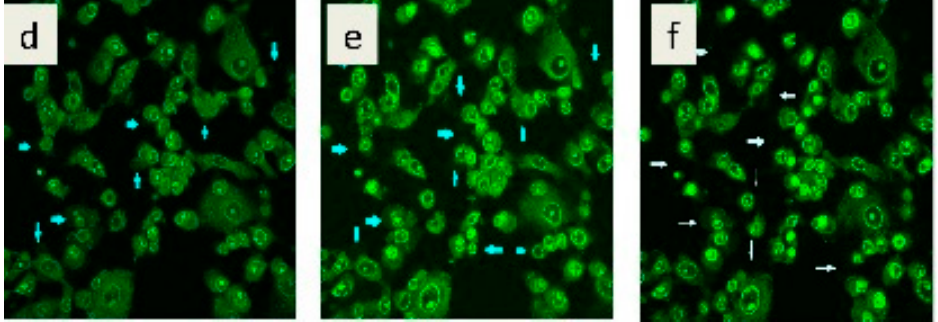
Figure 7. Confocal laser scanning microscopic imaging indicating the development of vacuoles formation as a function of incubation time: ( a ) at zero time, no vacuole formed; ( b ) after 2 h, start vacuoles formation (arrows); ( c ) after 4 h, increase vacuolization rate (arrows); ( d ) after 6 h, increased vacuoles size (arrows); ( e ) after 8 h, intact vacuoles outside cells (arrows); and ( f ) after 10 h, over vacuolization everywhere from all cells sides (arrows). Magnification 40×.